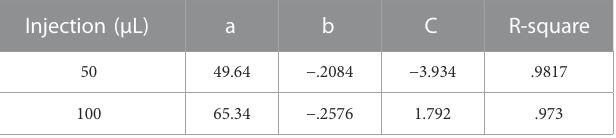
TABLE 2 Values for the power law coef fi cients with R-square values presenting quality of fi tting. Coef fi cients of the power law fi tting, f (x) = a · x b + C, with R-square values presenting quality of fi tting.